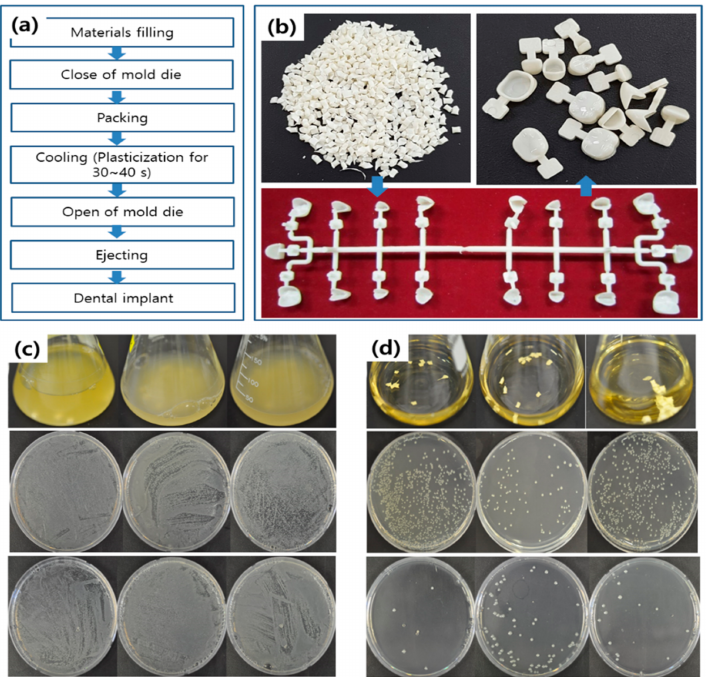
Figure 6. ( a ) Typical processing of implant fabrication. ( b ) Dental implant fabricated from propolis- embedded zeolite and PLA/PCL polymer. Antibacterial activity against E. coli: ( c ) PLA-PCL composite pellets; ( d ) propolis-embedded zeolite/PLA-PCL nanocomposite pellets.